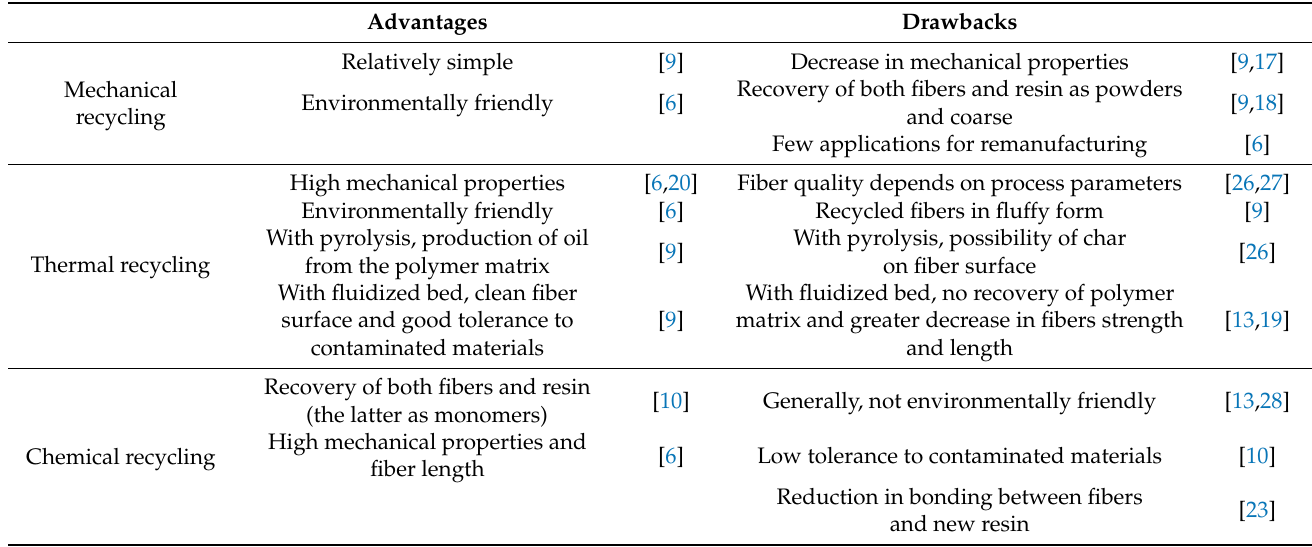
Table 1. Advantages and drawbacks of recycling processes.